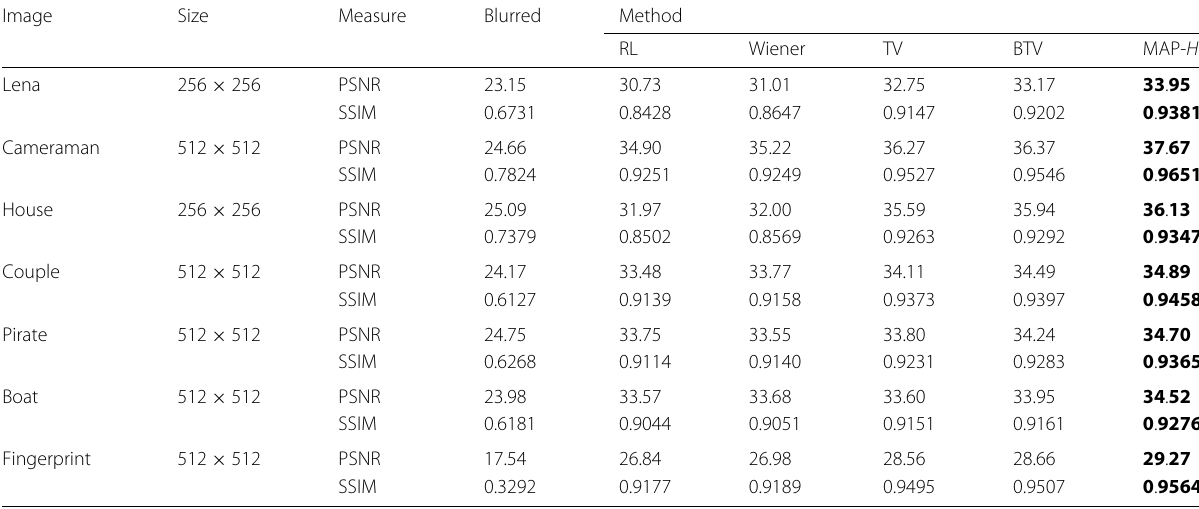
RL Wiener TV BTV MAP- H 1